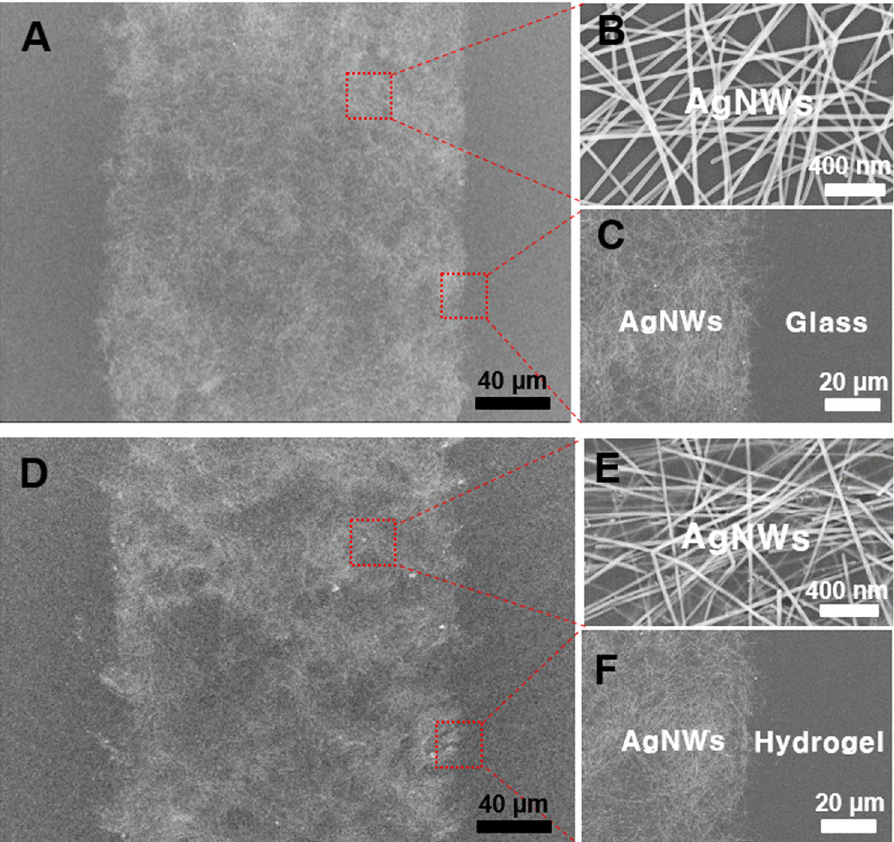
Figure 3. FE-SEM images of ( A – C ) AgNW-based micropatterns on a glass substrate before the pattern transfer process and ( D – F ) AgNW-based micropatterns on a hydrogel substrate after pattern transfer process. The line pattern width is 200 μ